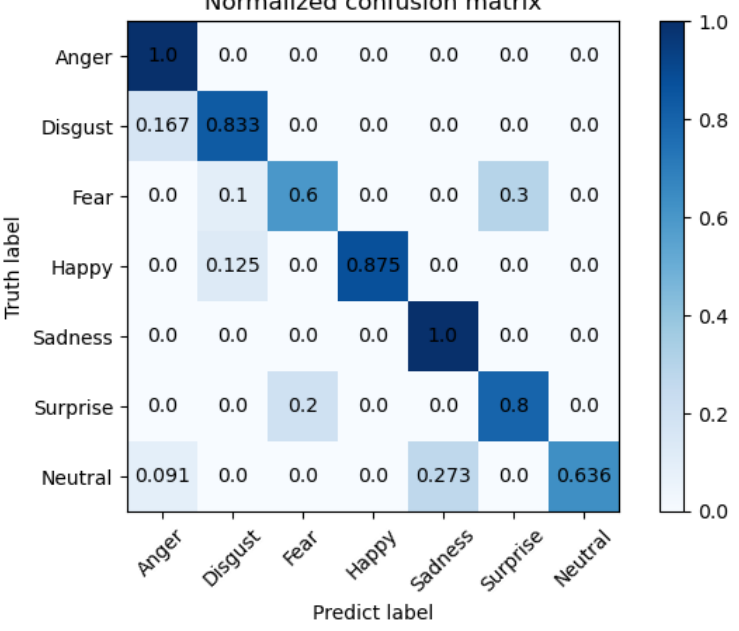
Figure 6. Confusion matrix on Bosphorus dataset for seven expressions.